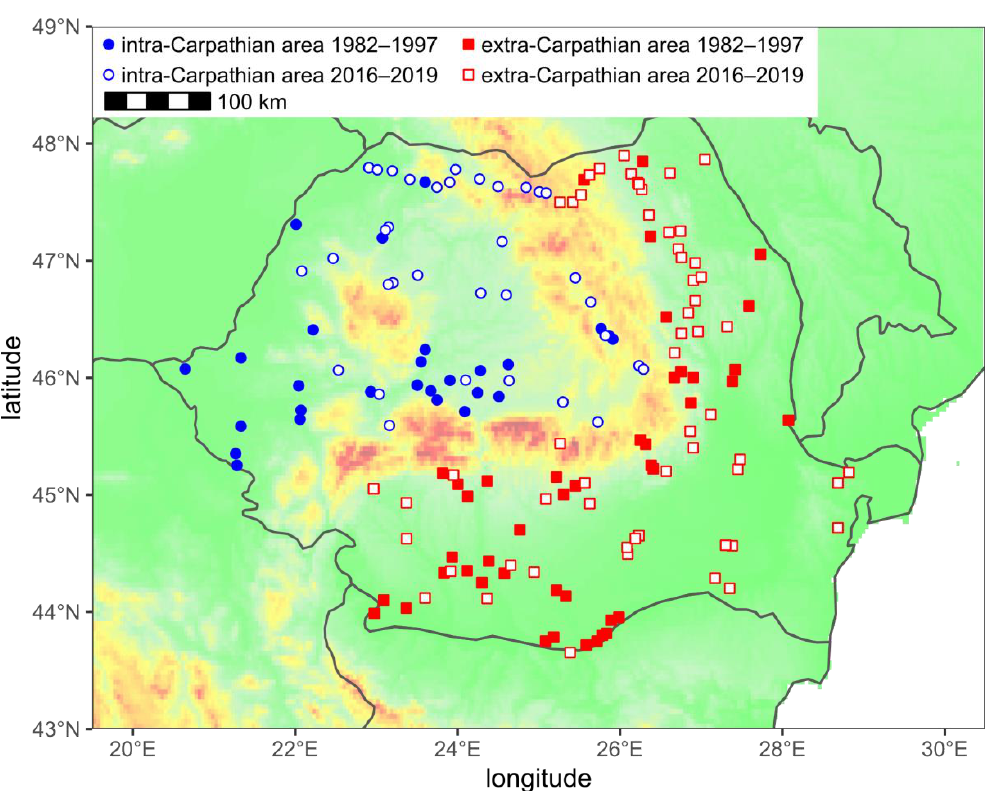
Figure 1. A map of the study area. The markers indicate the locations from which the samples were collected. The background colours from green to red indicate increasing elevation.